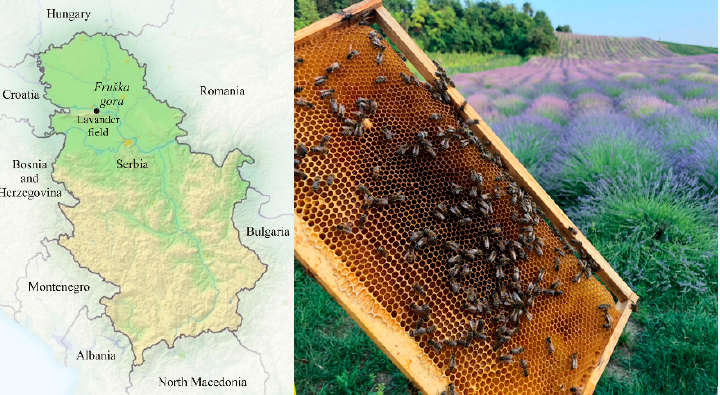
Figure 1. Field location and lavender field in full blooming with honeybees.